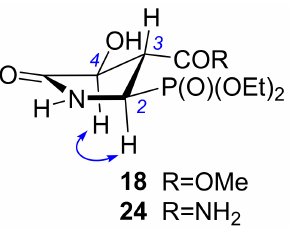
Figure 4. The preferred conformations of 18 and 24 with the most important NOESY correlations (blue arrow).